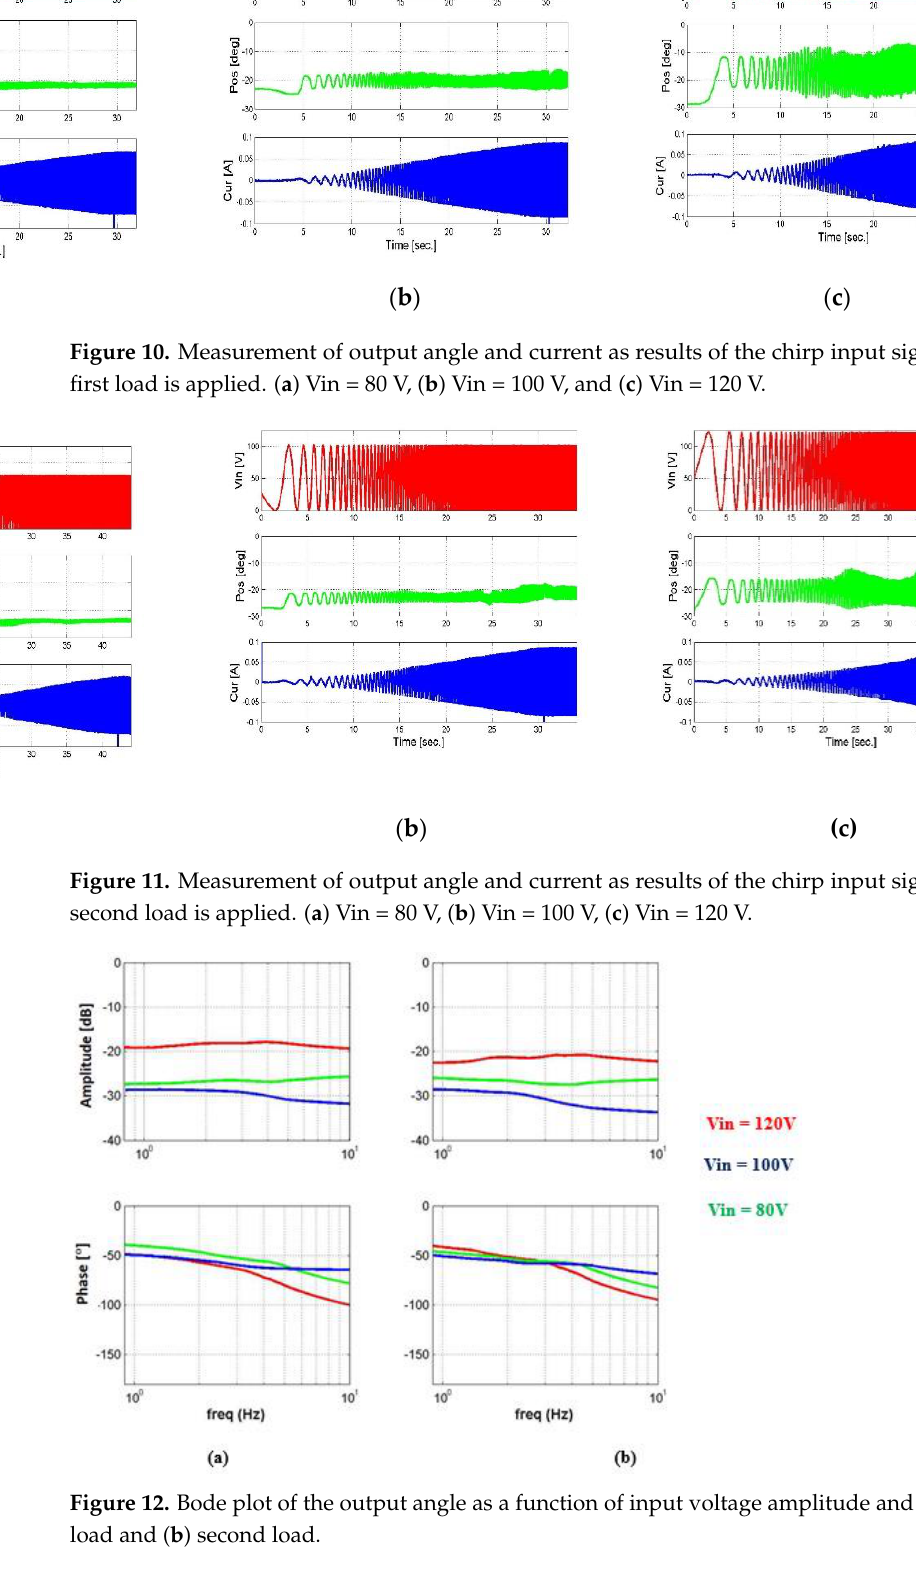
Figure 13. Bode plot of current as a function of input voltage amplitude and load. The transfer function was then re-evaluated using a Matlab function called Invfreqs. This function completes calculations using the least-square analog filter corresponding to the input and output signals, as fully described in Sect. 2 4.2.2. Position Feedback Transfer Function Adjustment Following the calculation of a uniform and normalized transfer function, which is suitable for the different voltage levels and the different loads, calibration of the function for the various input voltages was performed. That is, for each input voltage the gain in which the uniform function was multiplied is determined. The amplification is deter- mined by the following equation: